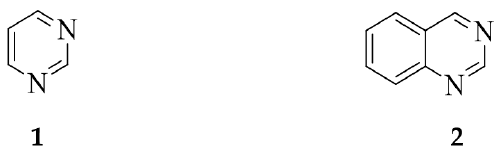
Figure 1. Structures of pyrimidine 1 and quinazoline 2 .